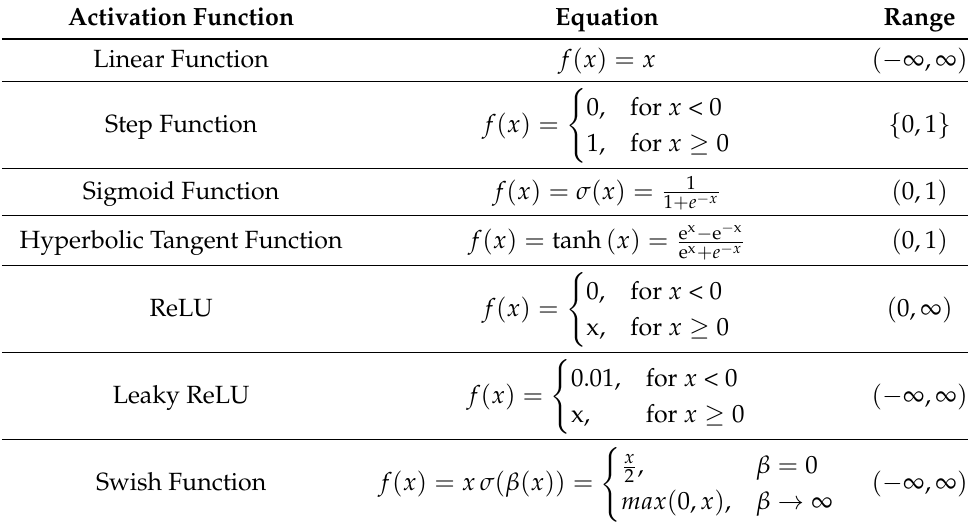
Table 1. Mathematical expressions of activation